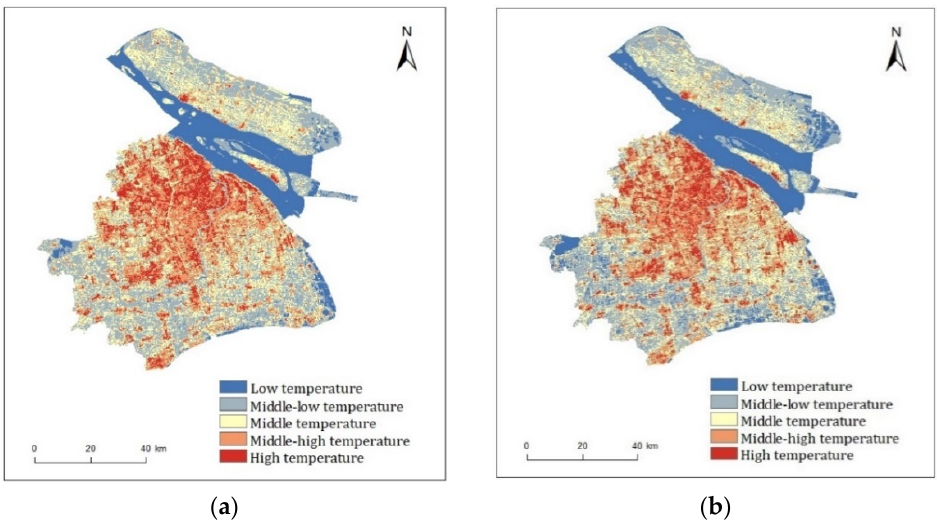
Figure 3. Land surface temperature derived from Landsat-8 OLI/TIRS images for the study area